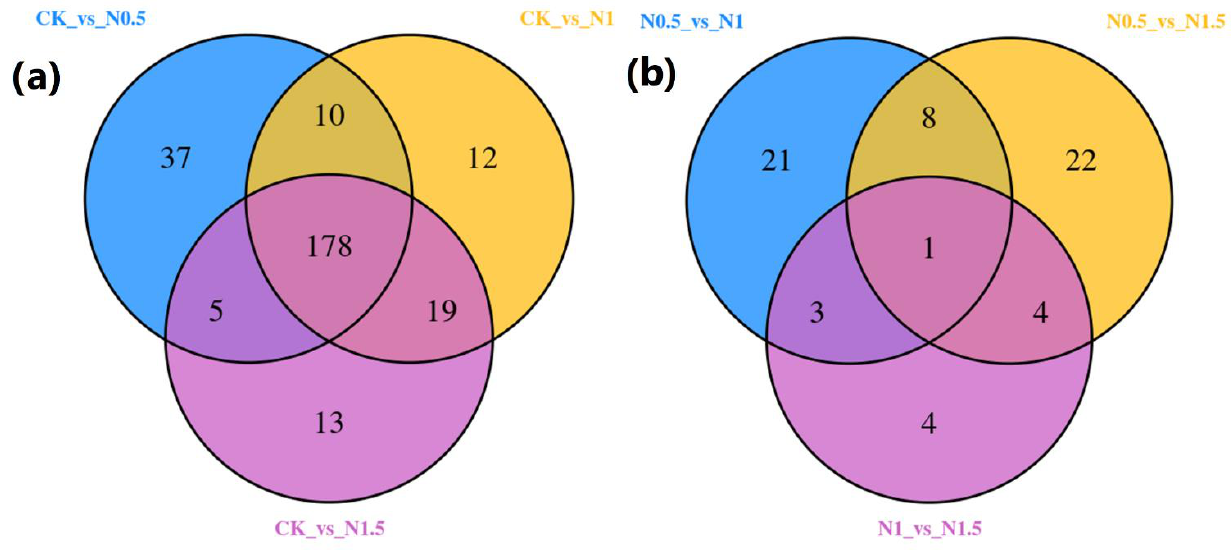
Figure 7. Venn diagrams representing the consensus results of DAMs for the classification of the samples via metabolites accumulation in treated samples, which were created with the statistical package edgeR using three biological replicates for comparing CK and NaCl-treated seedling sample comparison groups (CK: no treatment; N0.5: NaCl treatment for 0.5 h; N1: NaCl treatment for 1 h; and N1.5: NaCl treatment for 1.5 h. ( a ) CK-vs.-N0.5; CK-vs.-N1; CK-vs.-1.5; ( b ) N0.1-vs.-N1, N0.5-vs.-N1.5, and N1-vs.-N1.5).